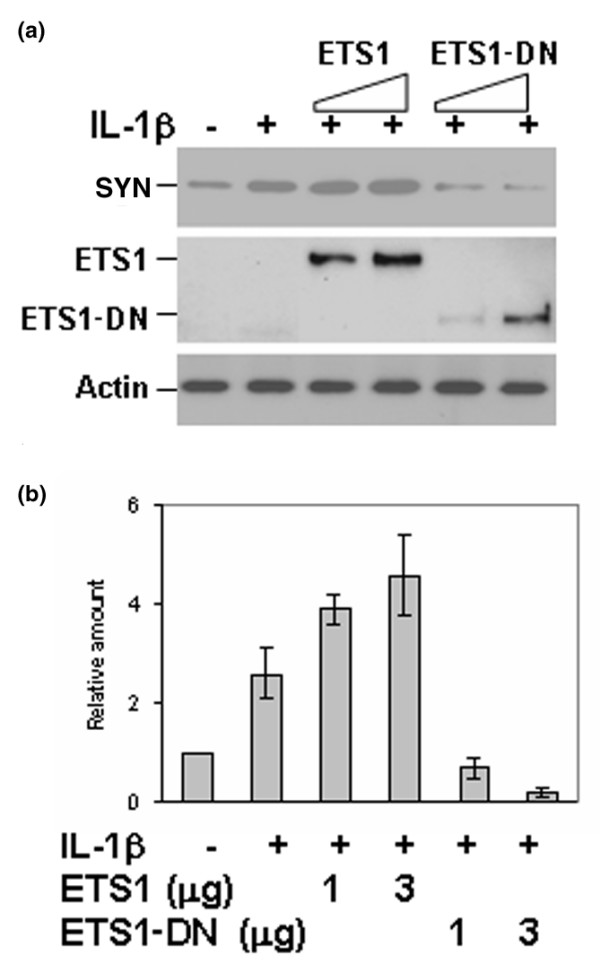
ETS1 is involved in interleukin-1β(IL-1β)-induced Synoviolin (SYN) expression. (a) ETS1 or ETS1-DN expression plasmids were transfected into mouse synovial fibroblasts. Cells were then cultured in medium containing 10 ng/ml of IL-1β for 48 hours. The expression of SYN was detected by Western blotting (top panel). The expression of ETS1 and its mutant was detected with anti-ETS1 antibody (middle panel). The same membrane was stripped and reblotted with anti-actin antibody (bottom panel).(b) The expression level of SYN was quantified. Error bars represent three independent experiments (mean ± standard deviation). ETS1-DN, dominant negative mutant of ETS1.